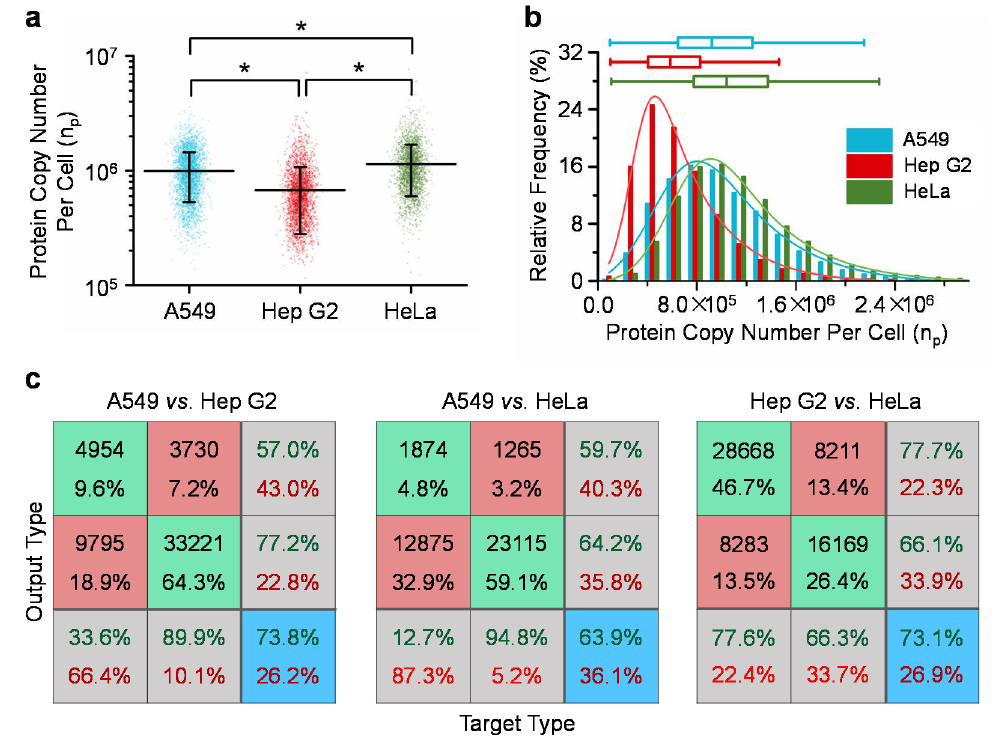
Figure 3. ( a ) Scatter plot of the absolute copy numbers of single-cell β-actin proteins of A549 (n cell = 14,754), Hep G2 (n cell = 36,949) and HeLa (n cell = 24,383) cells with means and standard deviations included (* represents the statistical difference with p < 0.01); ( b ) Distributions of absolute copy numbers of β-actin proteins at the single-cell level for A549, Hep G2 and HeLa cells with three quartiles and the quartile coefficients of dispersion included; ( c ) Neural network was used to evaluate the distribution differences of β-actin proteins among A549, Hep G2 and HeLa cells, producing successful classification rates of 73.8% for A549 vs. Hep G2 cells, 63.9% for A549 vs. HeLa cells and 73.1% for Hep G2 vs. HeLa cells.